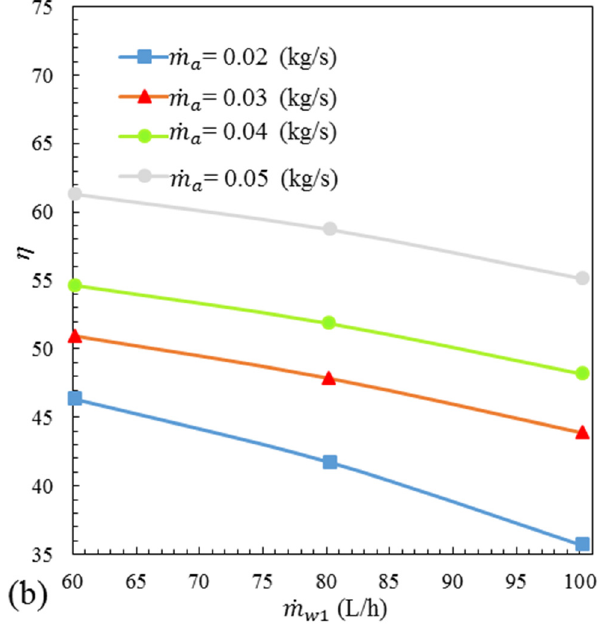
Figure 6. Cooling tower efficiency based on air flow rate at different water flow rates: ( a ) Efficiency versus air mass flow rate; ( b ) Efficiency versus water mass flow rate.